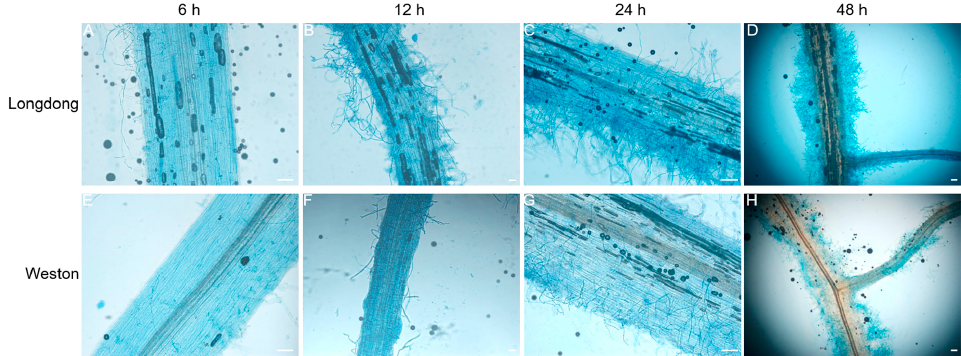
Figure 6. Microscopic observation of resistant or susceptible alfalfa varieties infected by Phytophthora cactorum at different time points. ( A – D ) Typical infection sites of Longdong roots inoculated with the P. cactorum strain, showing greater mycelium proliferation and tissue invasion within tissue. ( E – H ) The infection sites of Weston infected with P. cactorum , showing less mycelial infection. Different root tissues were stained with the lactophenol-trypan blue for 30 s before microscope observation. Infectious growth was observed from 6 hpi to 24 hpi. Scale bars = 200 μ m.